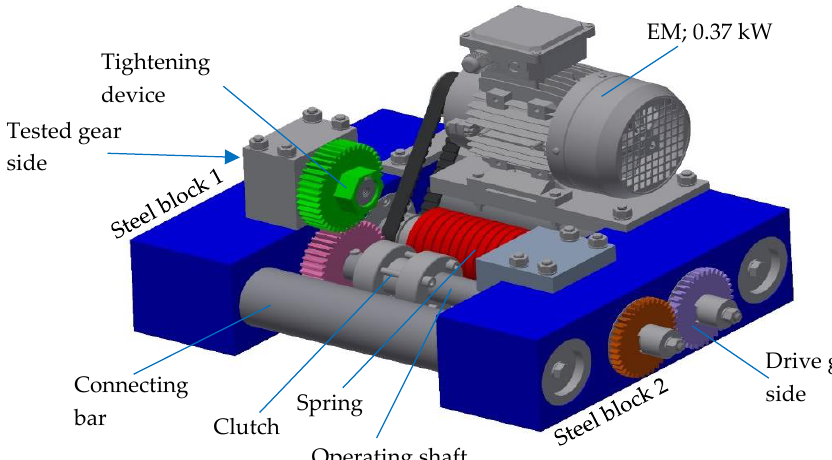
Figure 7. The principle of the testing rig.